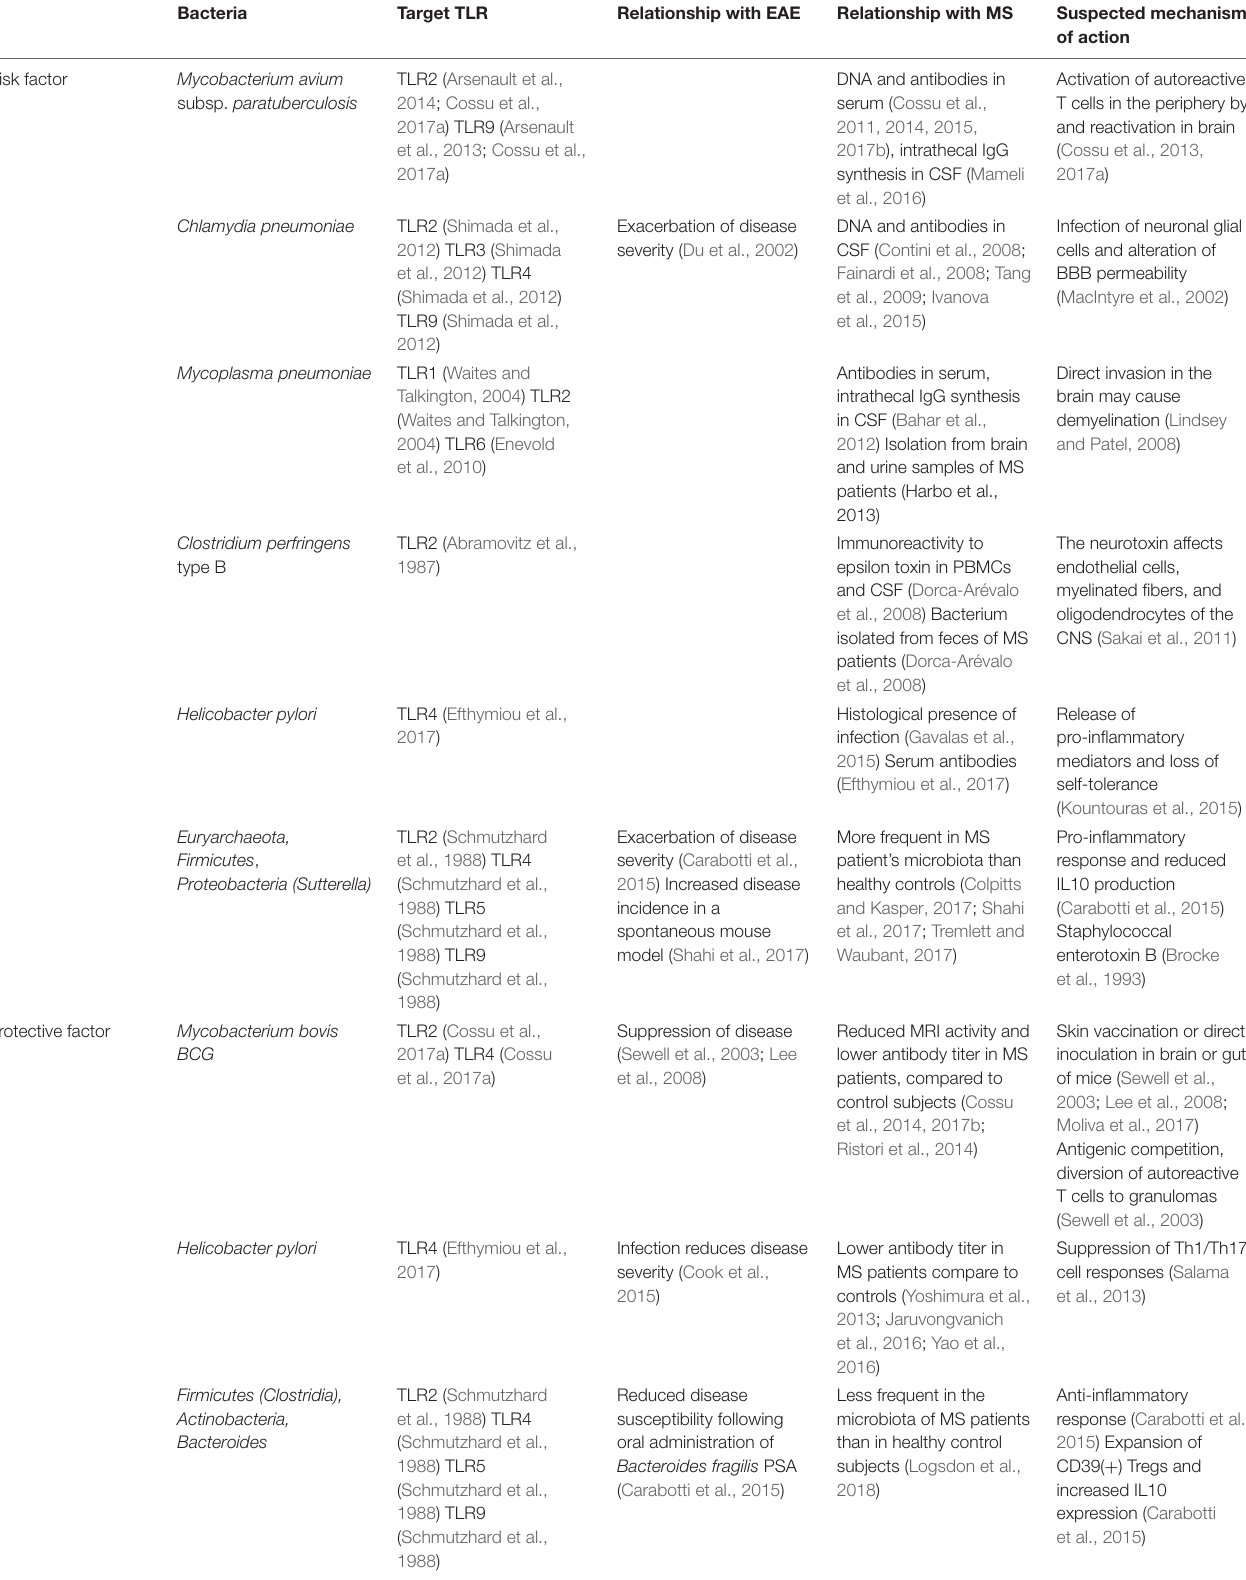
TABLE 1 | Summary of the major bacteria linked to